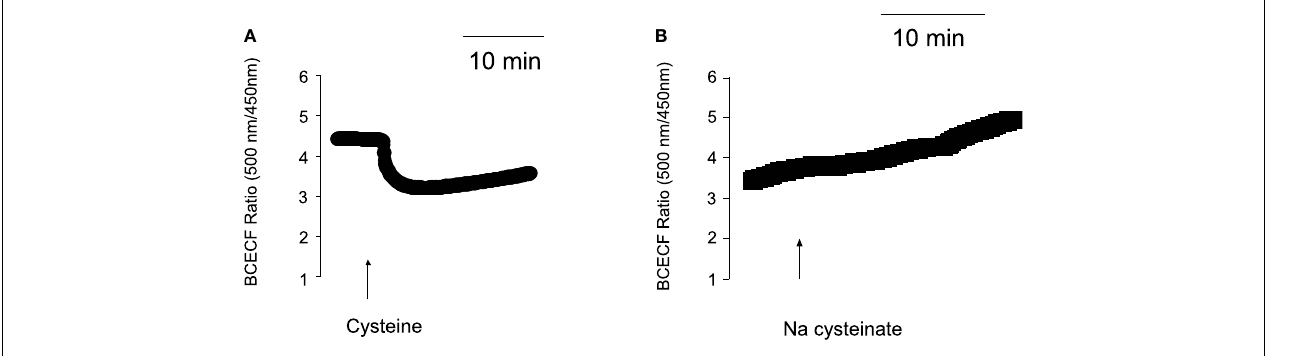
FIGURE 3 | (A) Cysteine, but not Na cysteinate induces a cytosolic acidification. Free cysteine (10 − 2 mol · l − 1 ; indicated by the arrow) induced a fall in the BCECF ratio signal.Values are given as means (symbols) ± SEM (lines), n = 72. (B) The response was not mimicked by Na cysteinate (10 − 2 mol · l − 1 ;